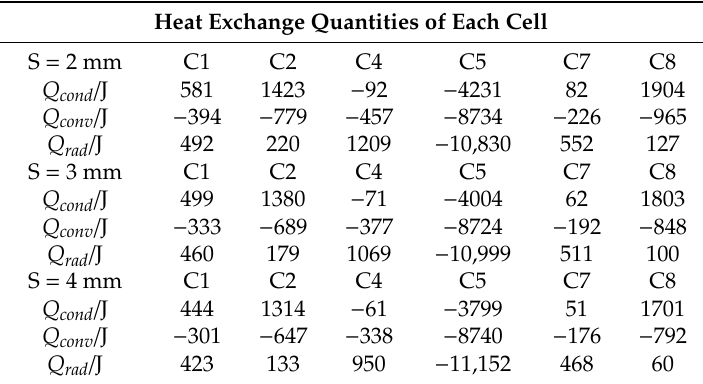
Table 2. Heat exchange quantities of each cell when S = 2, 3 and 4